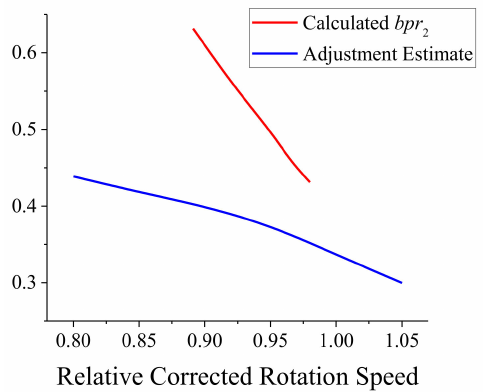
Figure 13. The Second Bypass Ratio vs. Relative Corrected Rotation Speed of AFS (Mode 2 with af-